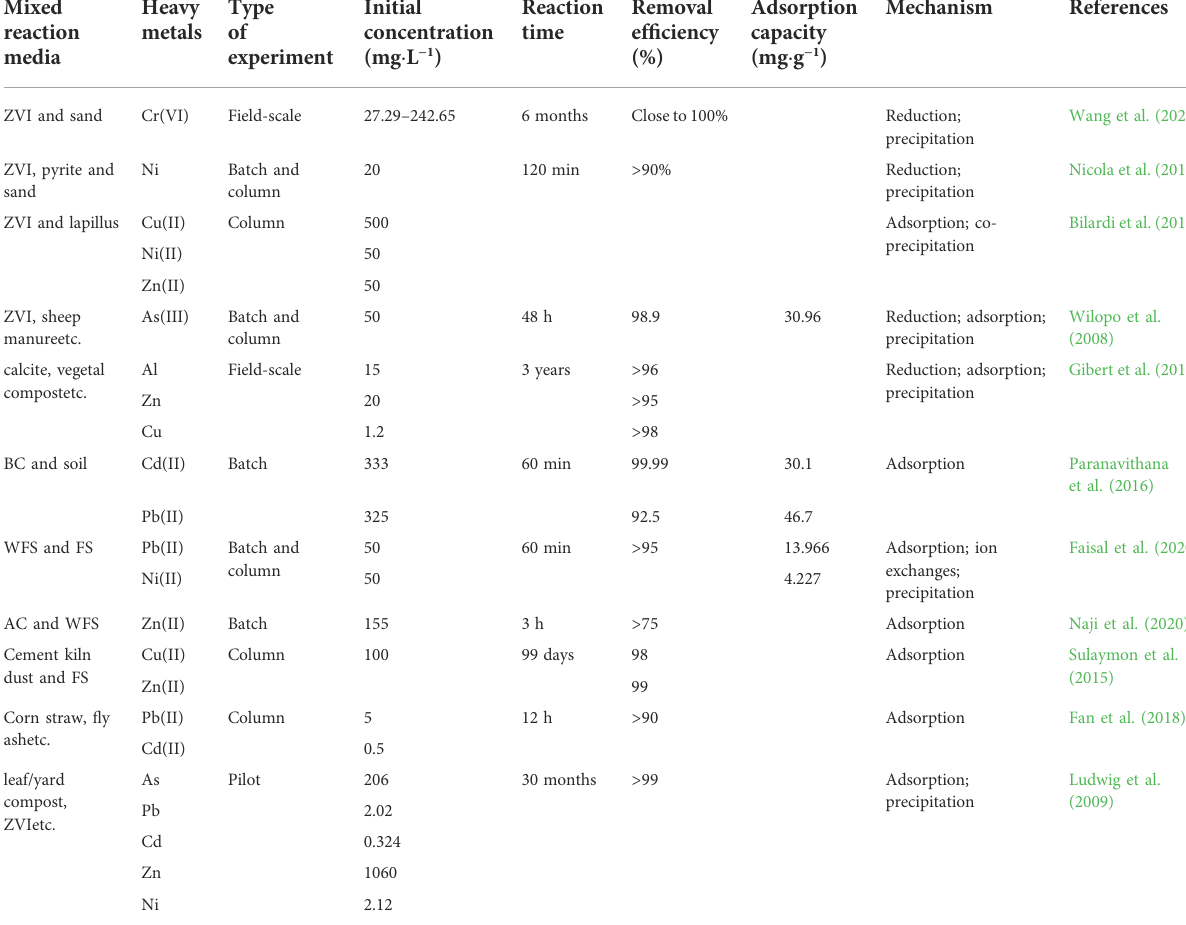
TABLE 2 Application of mixed reaction medium in PRB treatment of groundwater heavy metals. Mixed